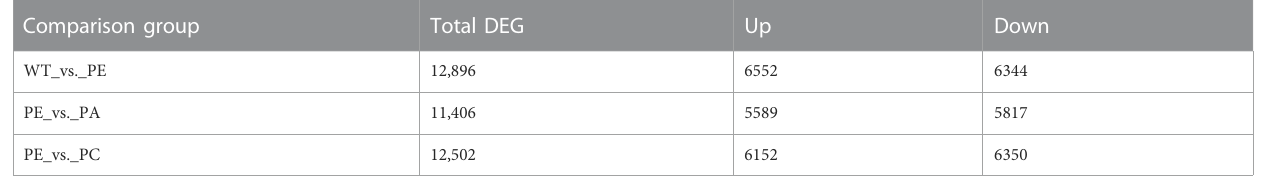
TABLE 2 DEGs in comparison groups. Comparison group